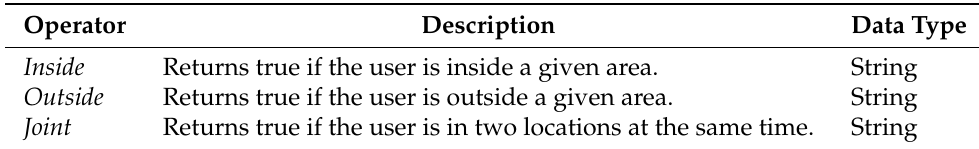
Figure 6. Alimentation. Table 12. Location-based operators.